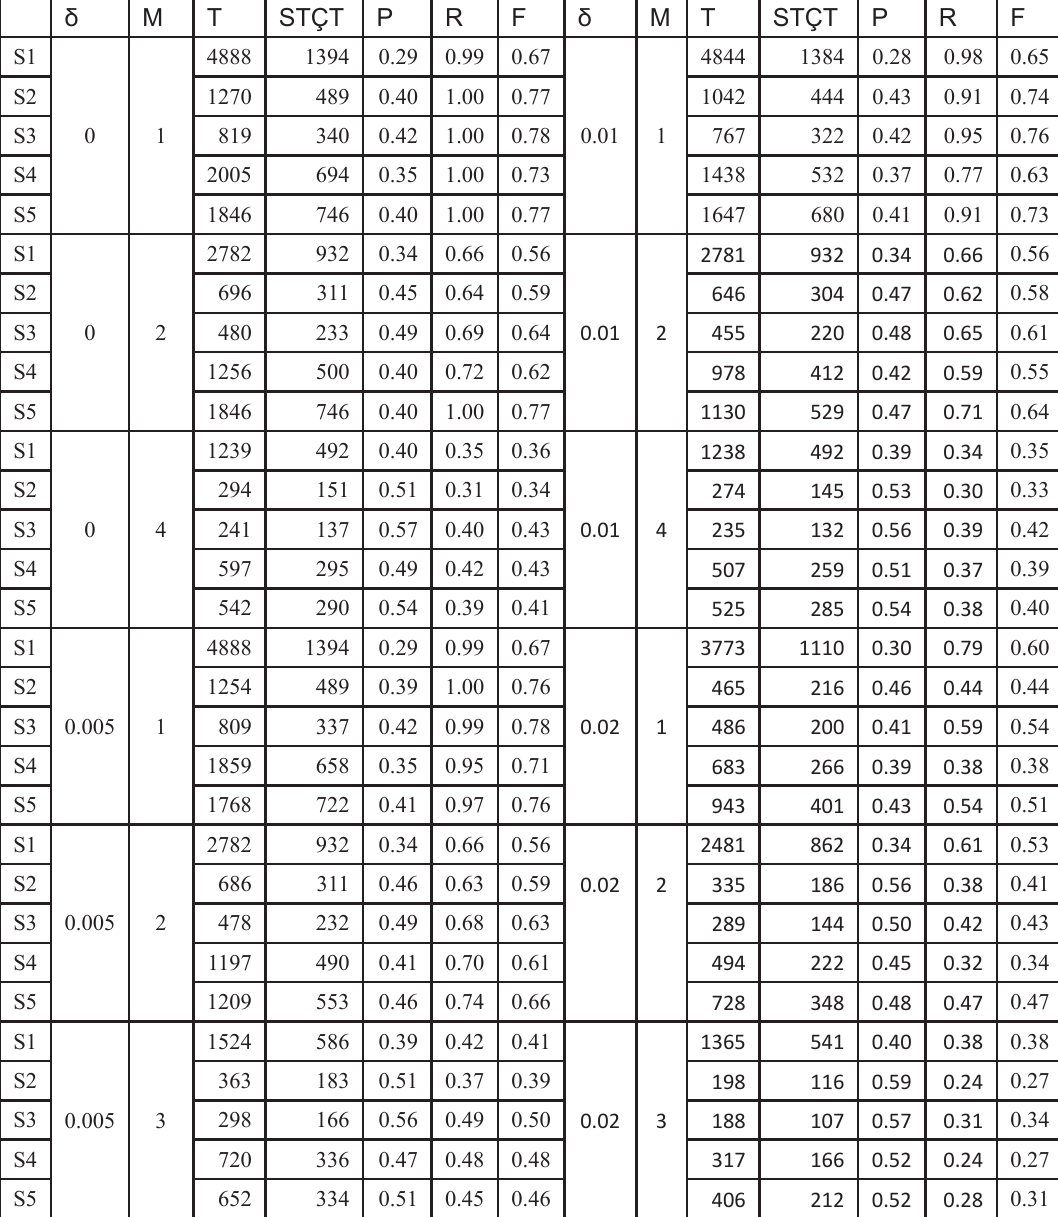
The Performance of Concept